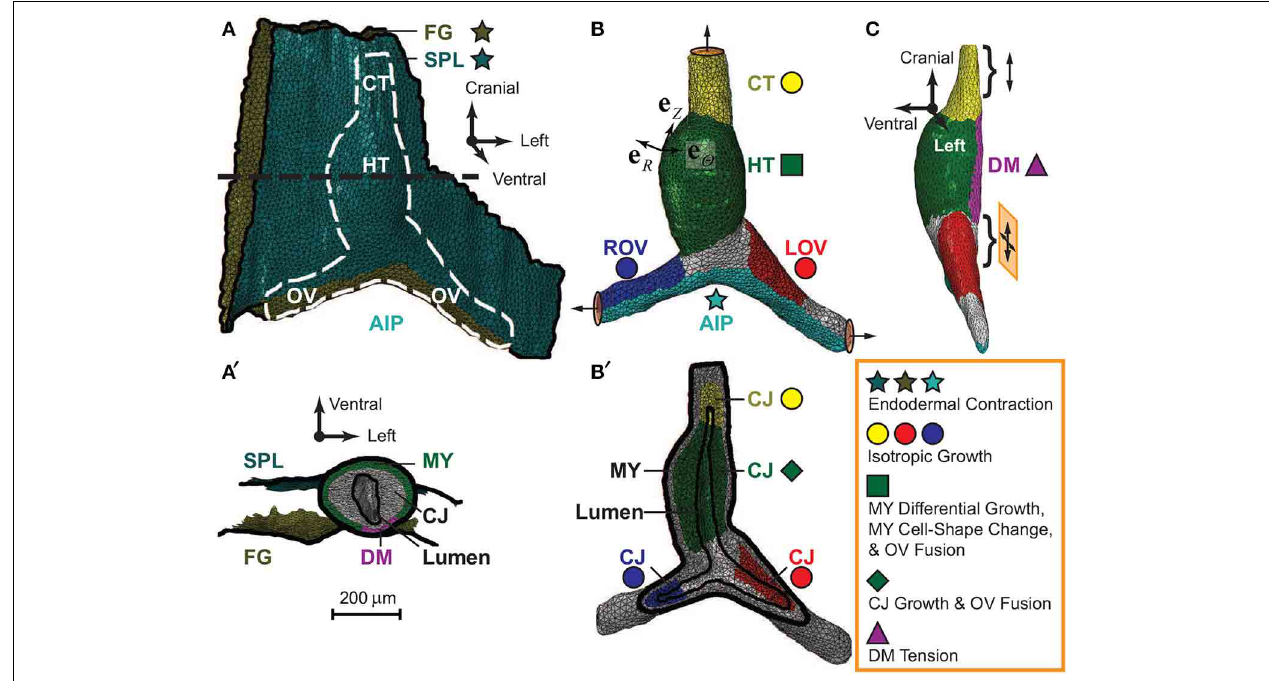
FIGURE 3 | Finite-element model for embryonic heart. Model geometry in undeformed configuration was reconstructed from OCT images of a representative HH10- heart. (A) The complete model (ventral view) consists of the heart [white dashed line; see also (B) ], which is sandwiched between the splanchnopleure (SPL) and the ventral wall of the foregut (FG). The caudal end of the SPL is attached to the caudal side of the omphalomesenteric veins (OVs) around the anterior intestinal portal (AIP), and the other membrane boundaries are fixed (black solid lines). (B) The heart model (ventral view) includes the heart tube (HT), conotruncus (CT), and the left and right OVs (LOV and ROV). The ends of the CT and OVs are constrained to move along the normal directions on their boundary surfaces (circular discs with arrows). (C) The dorsal mesocardium (DM), a narrow region along the dorsal side of